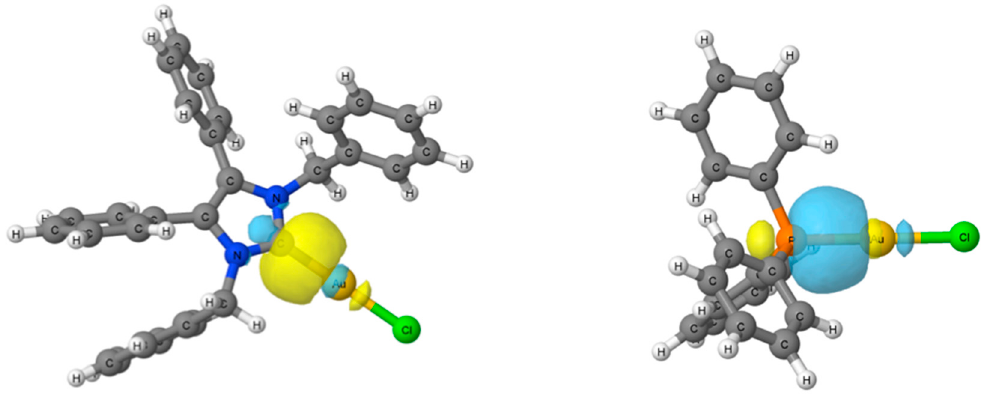
Figure 7. Molecular orbital corresponding to the σ -C–Au and σ -P–Au bonds of NHC*-AuCl and Ph 3 P-AuCl respectively.